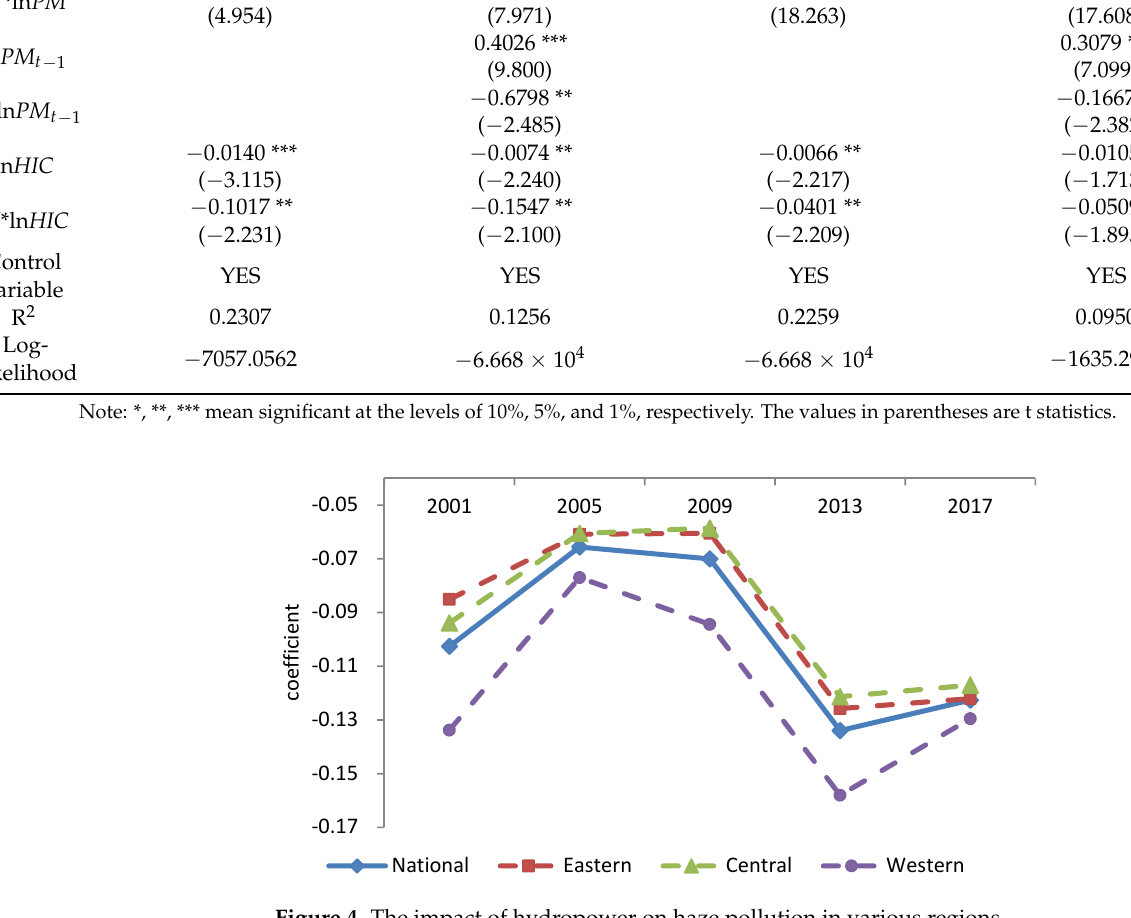
Figure 4. The impact of hydropower on haze pollution in various regions.